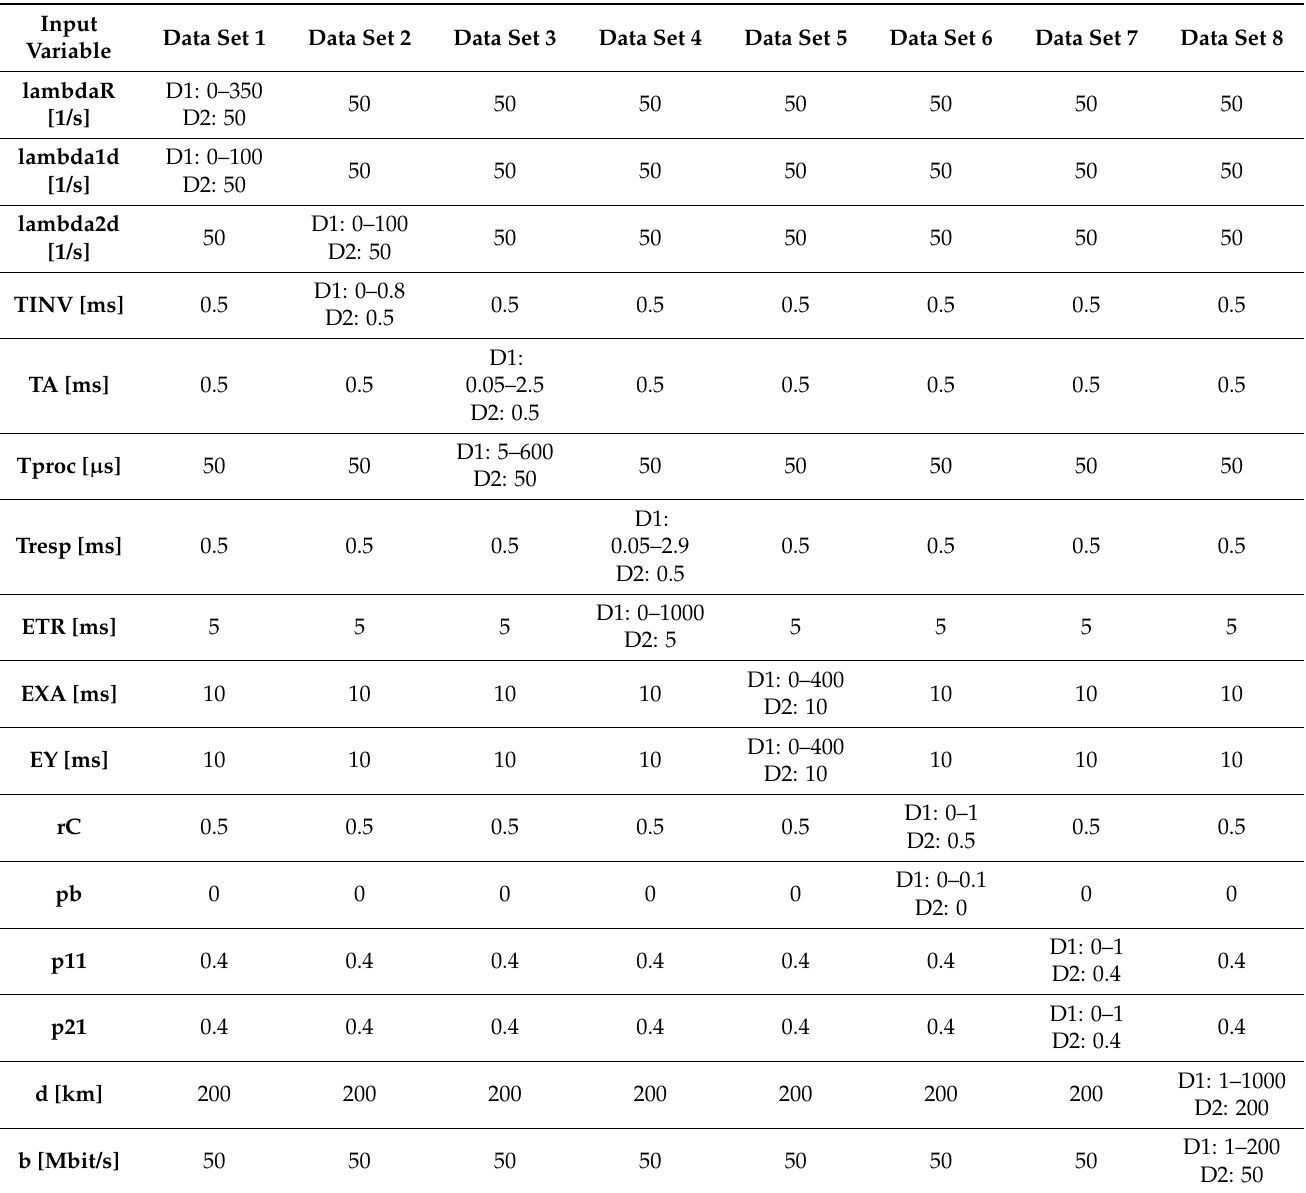
Table 2. Input data sets (D1 represents values of input variables for domain 1; D2—domain 2; when not specified, the same values of input variables were applied for both